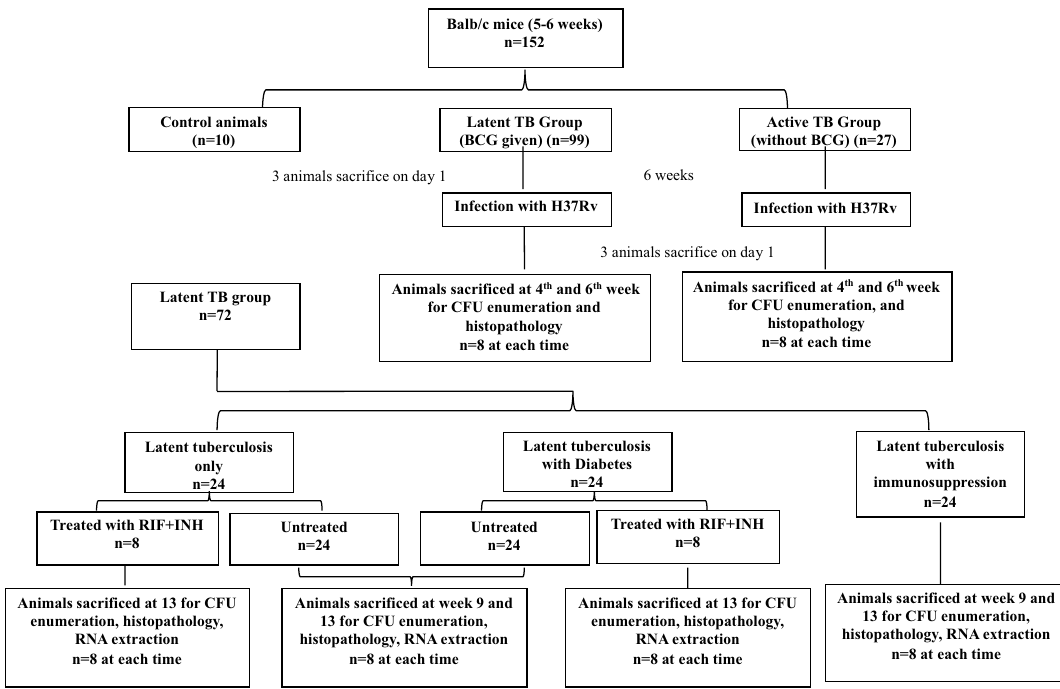
Figure 8. Flow chart depicting the experimental design, distribution of animals into different groups and time line of BCG infection, M. tuberculosis infection and subsequent